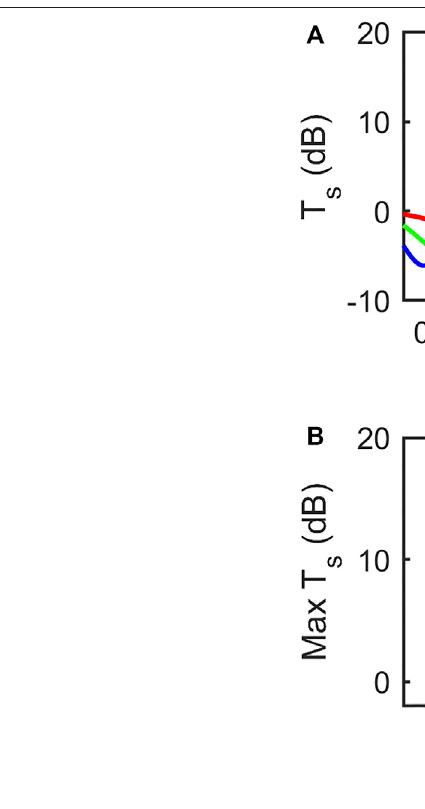
Frontiers in Physics |